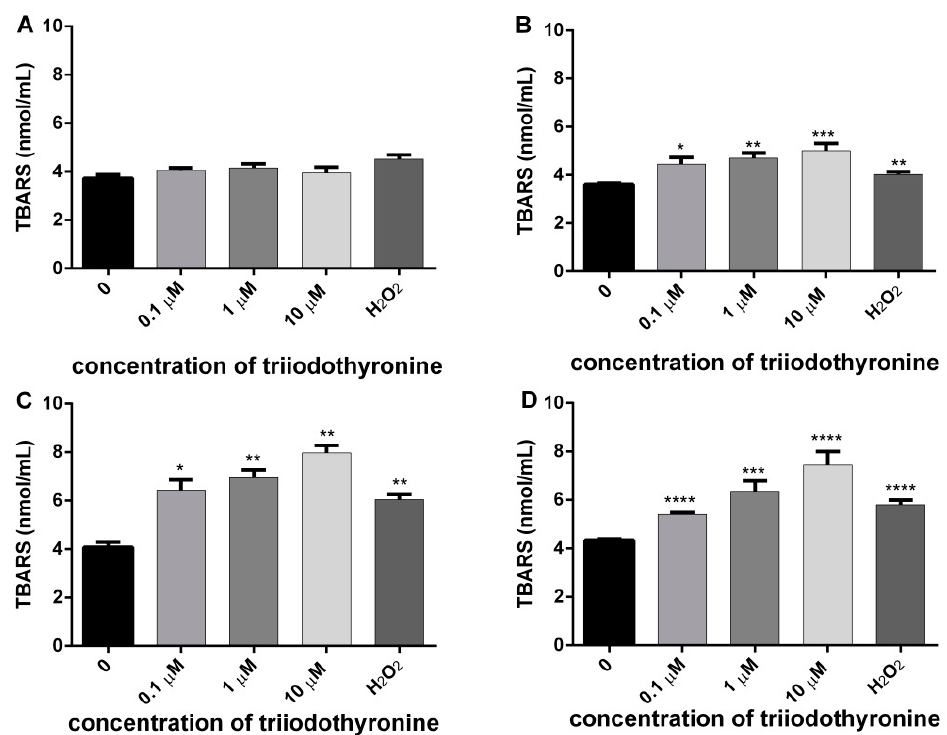
Figure 3. Concentrations of malondialdehyde (MDA) in lymphocytes of ( A ) normal, ( B ) obese, ( C ) prediabetics, and ( D ) T2DM patients treated with various concentrations of triiodothyronine and the positive control (H 2 O 2 ). The results are presented as means ± SEM. * p < 0.05, ** p < 0.01; *** p < 0.001; **** p < 0.0001 in comparison to the negative control, in one-way ANOVA by Dunnett test.